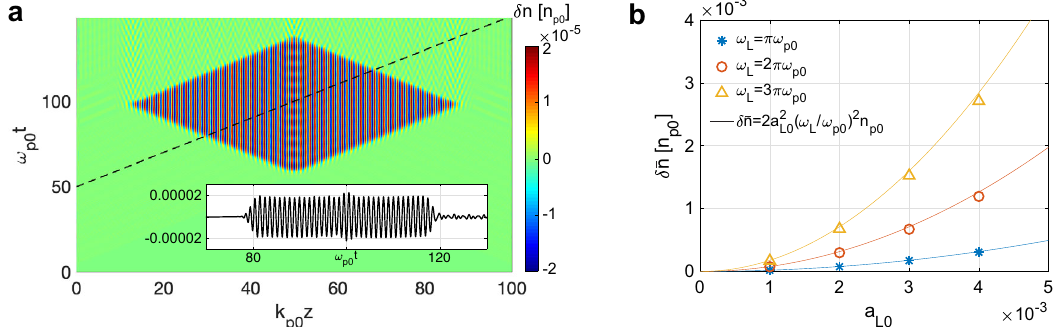
Fig. 5 Laser-modulated plasma. a The perturbed density distribution induced by the colliding lasers in the z − t plane from 1D simulations. The inset shows the density along the dashed trajectory. The lasers have a rising and falling edge 10 ω (cid:2) 1 the frequency and intensity of the colliding